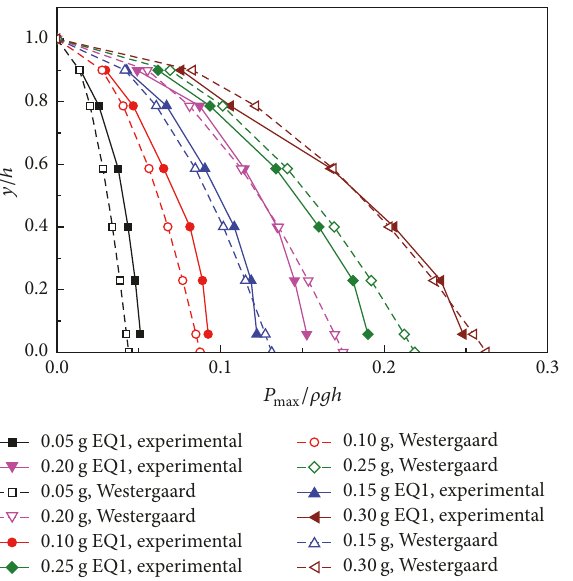
Figure 7: Comparison of the maximum hydrodynamic pressures acting on the wall at the vertical face due to the Wolong earthquake waveform (EQ1): experimental results and Westergaard’s formula.